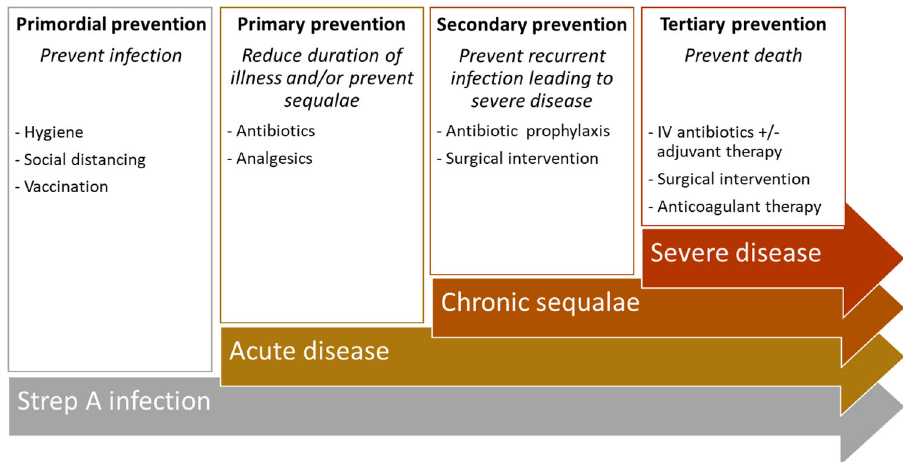
Fig. 2 Strep A prevention and treatment stratergies. A framework for the classi fi cation of treamtment and prevention stratergies avaiable between Strep A infection and severe